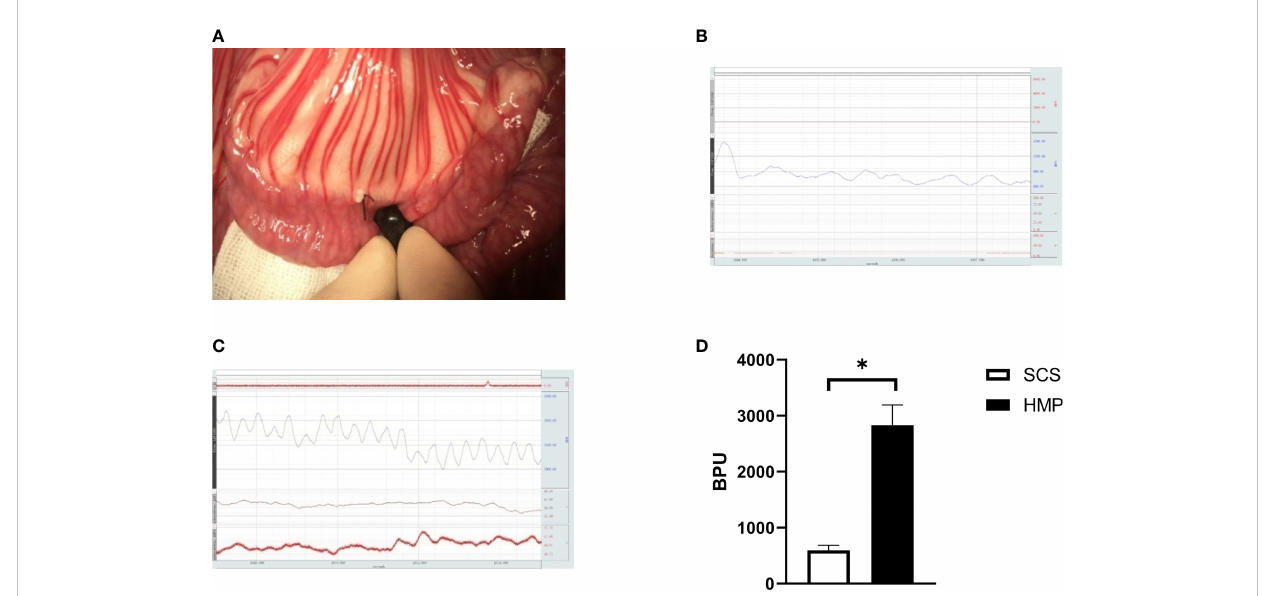
FIGURE 3 Comparison of microcirculation after blood restore during IT. (A) Detection of microcirculation of transplanted intestine by laser Doppler probe. (B) The microcirculation of HMP group at R0h, (C) The microcirculation of SCS group at R0h, (D) Evaluation of the microcirculation (n=5, *P